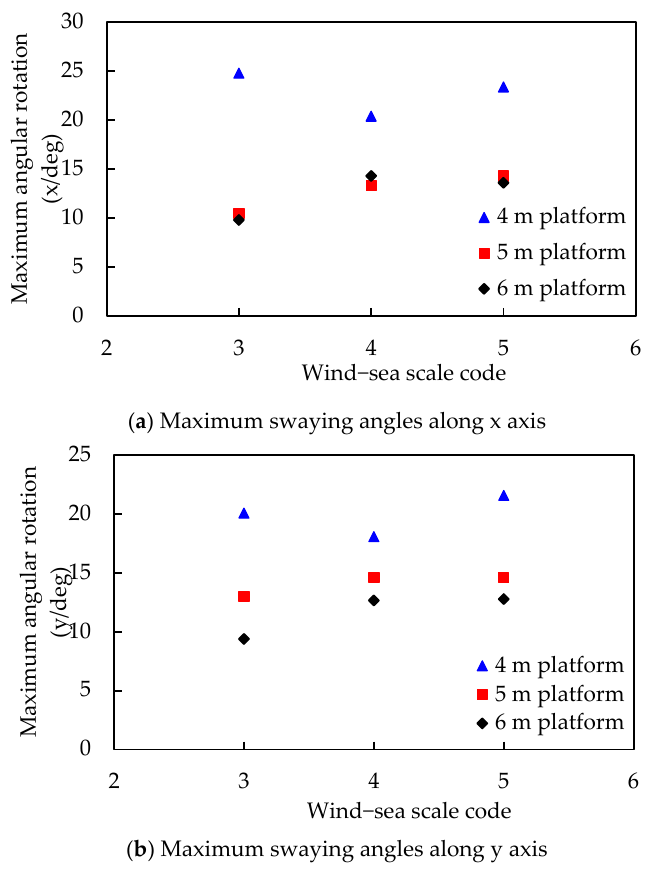
Figure 15. Maximum angular rotations of different size platforms under different wind − sea scales.